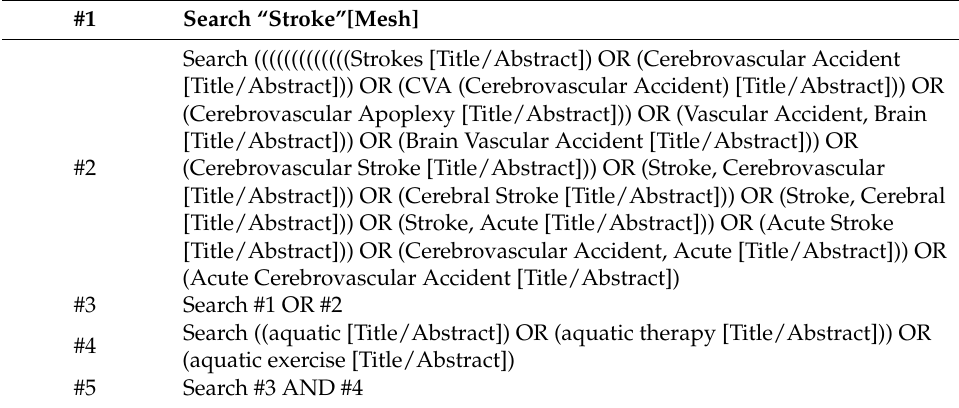
Table 1. Search strategy on